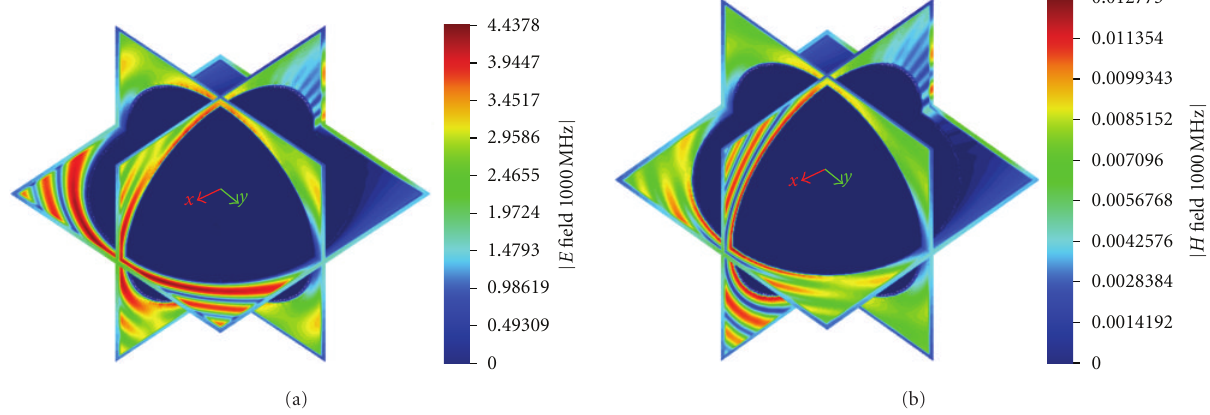
Figure 3: Smooth contour fill of near field distribution in frequency domain on three planes: x = 0 . 0, y = 0 . 0, and z = 0 . 0: (a) E field distribution and (b) H field distribution.